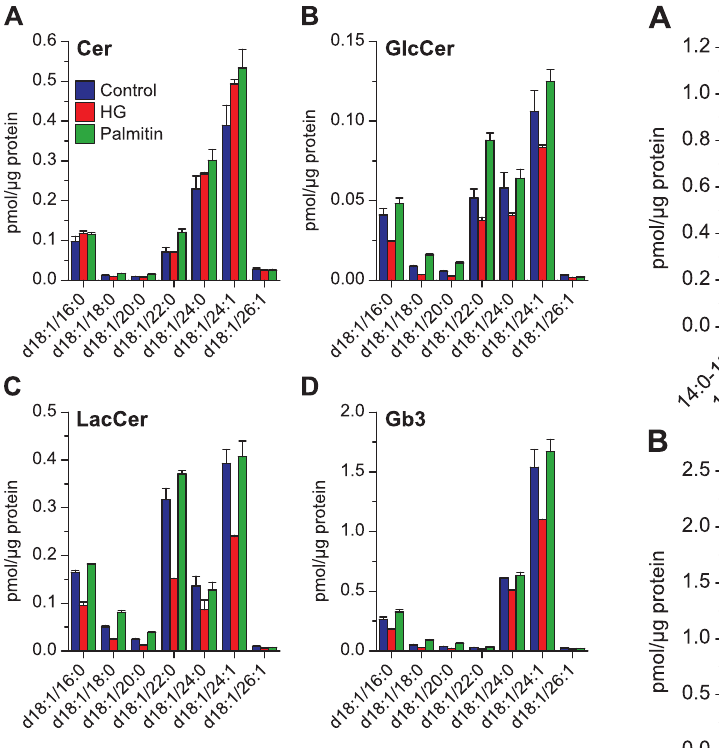
Figure 4. Quantitative analysis of ceramide and glycosphingo- lipids after HG or palmitin treatment. The major species of ( A ) Cer, ( B ) GlcCer, ( C ) LacCer, and ( D ) Gb3 in HEp-2 cells treated with HG (20 m M), palmitin (20 m M) or ethanol (0.1%, as control) for 24 hours. The species shown here are species comprising more than 1% of the total mass of any of the classes.